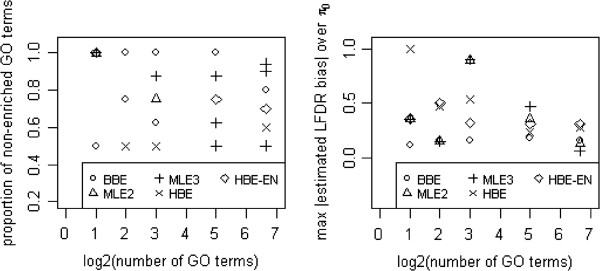
The performance comparison of LFDR estimators based on which estimator achieves the lowest absolute estimated LFDR bias at each combination ofΠ0 and m  (left) and, for each estimator, the maximum of absolute estimated LFDR bias over the proportion of non-enriched GO terms at each value of m  (right).